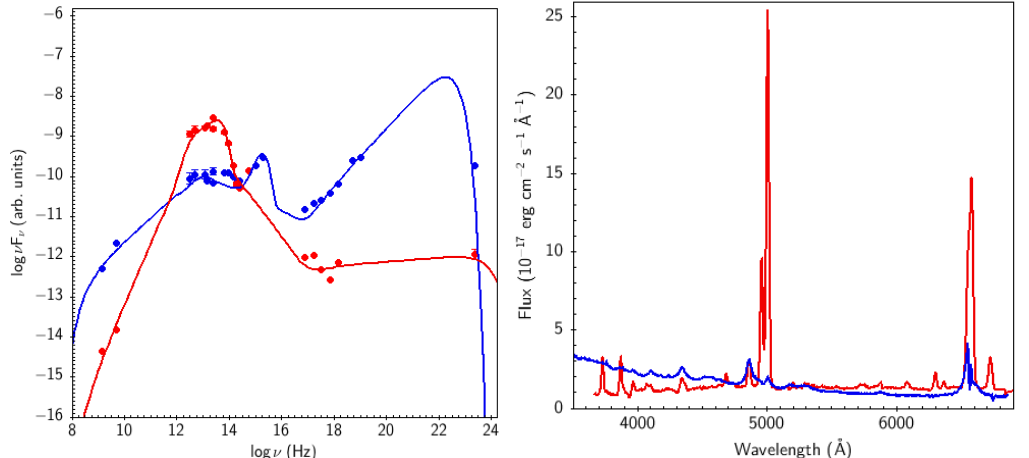
Figure 2. Examples of spectral energy distribution (SED) models ( left panel ) and optical spectra ( right panel ) for the prototypical Type 1 active galactic nucleus (AGN) 3C 273 (blue line and points) and the prototypical Type 2 AGN NGC 1068 (red line and points). The SEDs have been normalized to the same optical V-band magnitude and the models are based on the combination of two cut-off power laws and one black-body contribution. The spectrum of 3C 273 was observed at the Asiago Astrophysical Observatory, while the spectrum of NGC 1068 is taken from literature [16]. Both spectra were taken to rest-frame wavelength